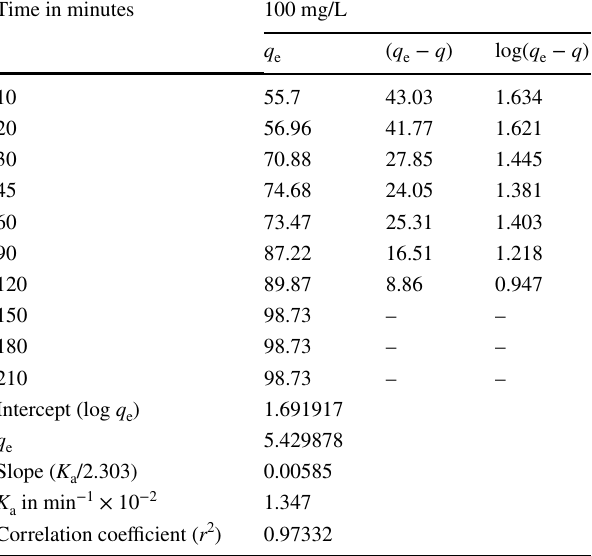
Table 2 Kinetic modelling for adsorption of lead(II) metal from aqueous solution using Lagergren’s equation onto CMAC (initial con- centration of lead(II) solution) Time in minutes